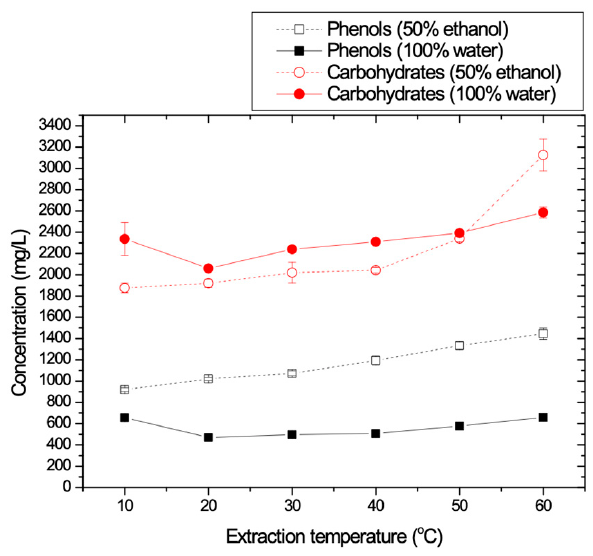
Figure 5. TPC and carbohydrates concentrations as a function of the extraction temperature.